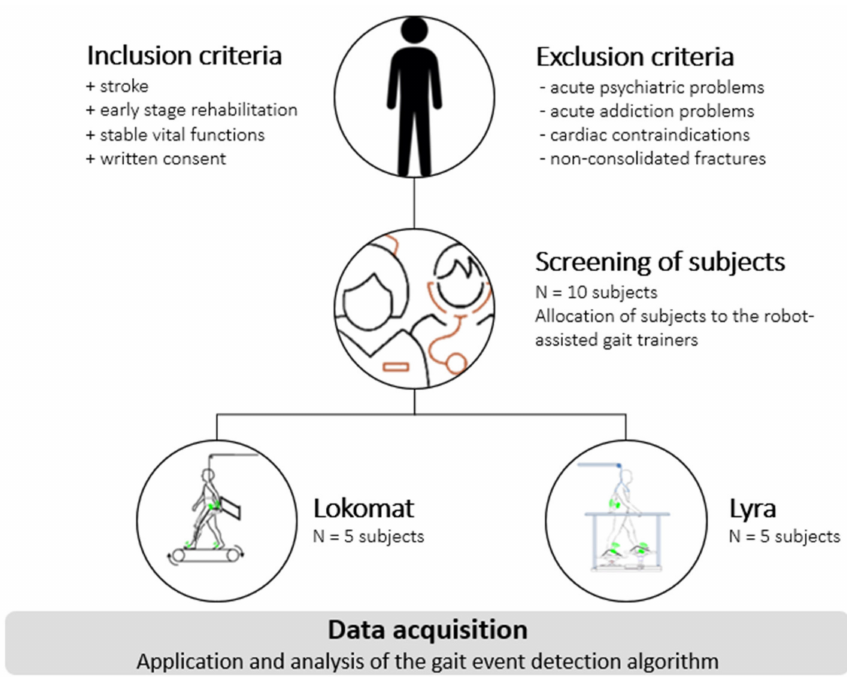
Figure 1. Study procedure.